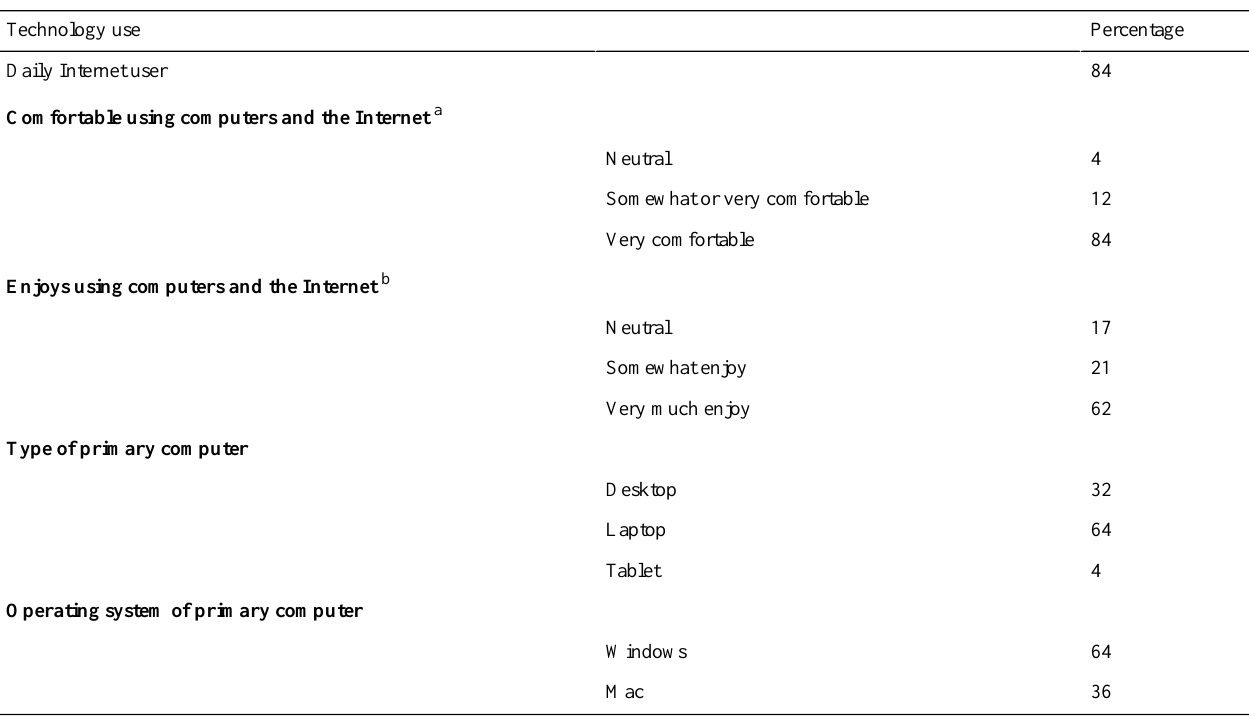
Table 2. Technology use of study participants